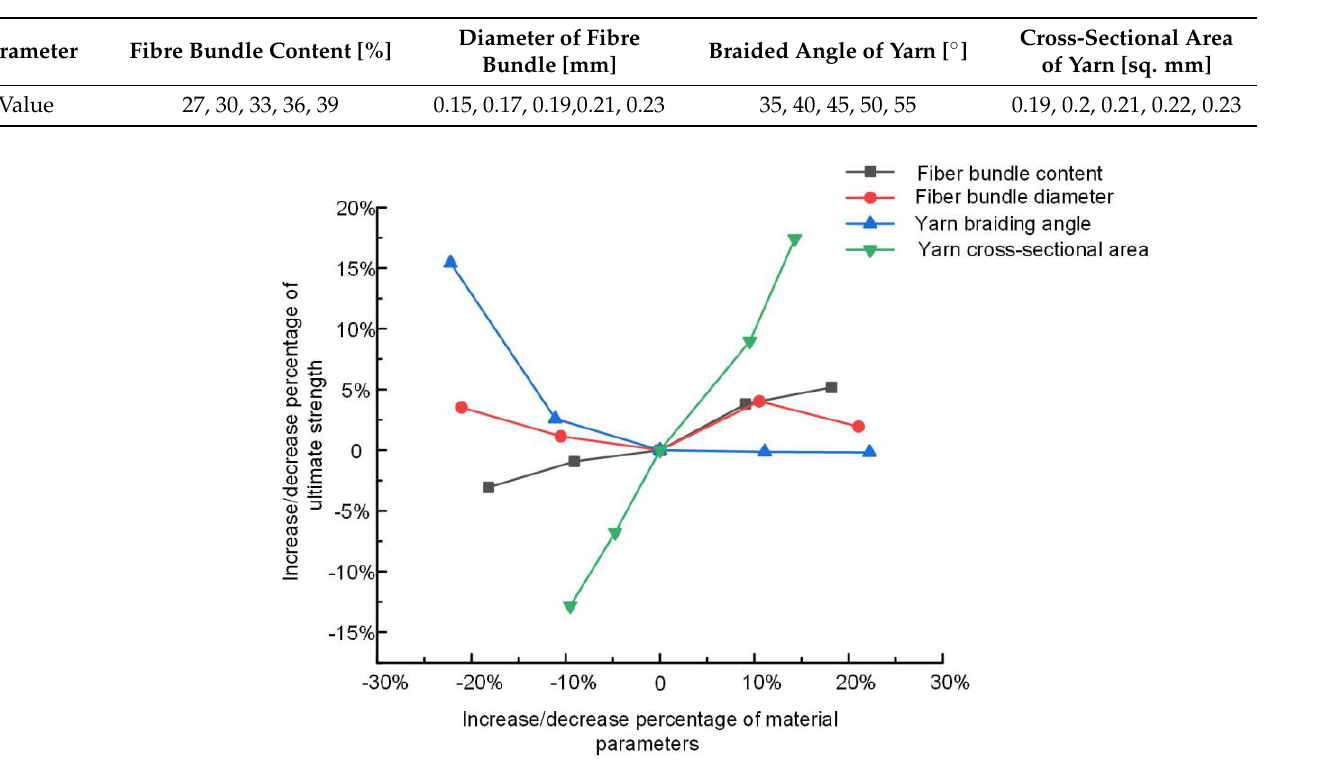
Figure 12. Effect of meso-scale material parameters on the ultimate strength of macro-scale stiffened panels.